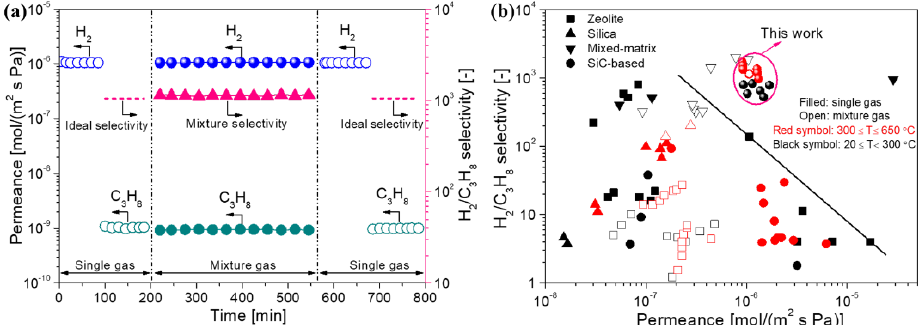
Figure 18. ( a ) Permeance and selectivity for H 2 /C 3 H 8 through PCS-derived membranes as a function of the test time at 500 °C (mixture: 50/50, feed pressure: 250 kPa (abs.), permeate pressure: 100 kPa (abs.)); ( b ) comparison of separation performance of various types of membranes for H 2 /C 3 H 8 at 20 °C – 650 °C. Adapted from [72] with permission from Elsevier.